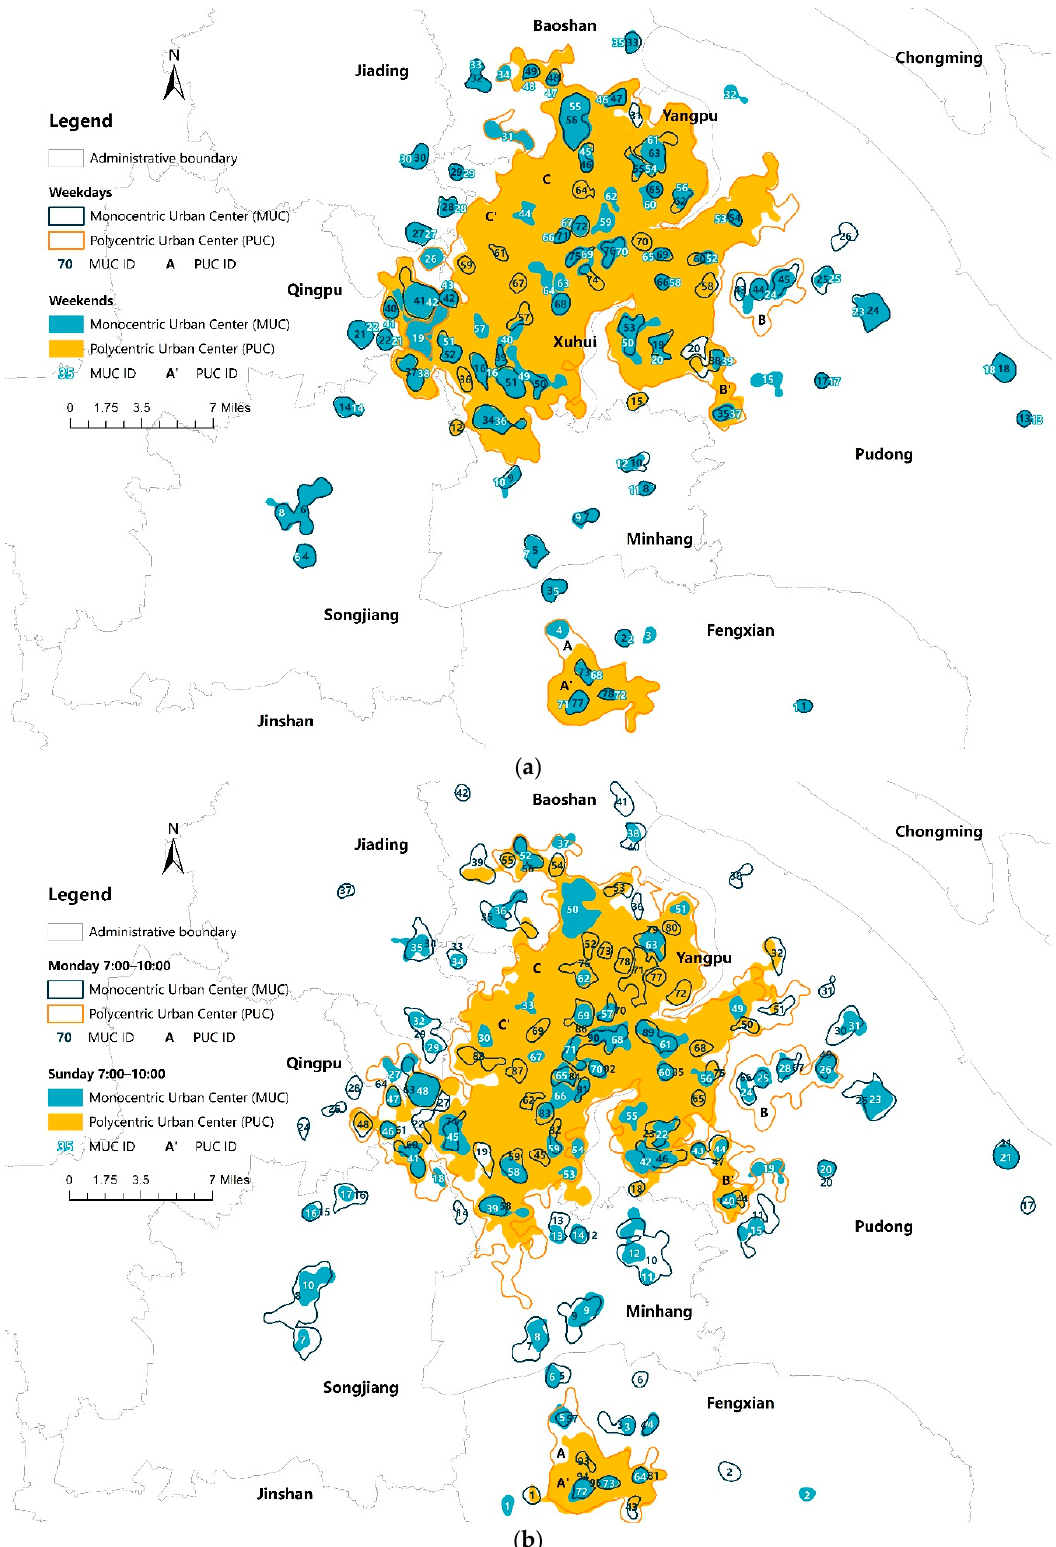
Figure 12. ( a ) A comparison between urban centers on weekends and weekdays; ( b ) a comparison between urban